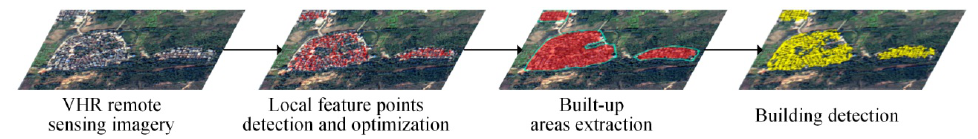
Figure 1. The flow chart of the proposed method.